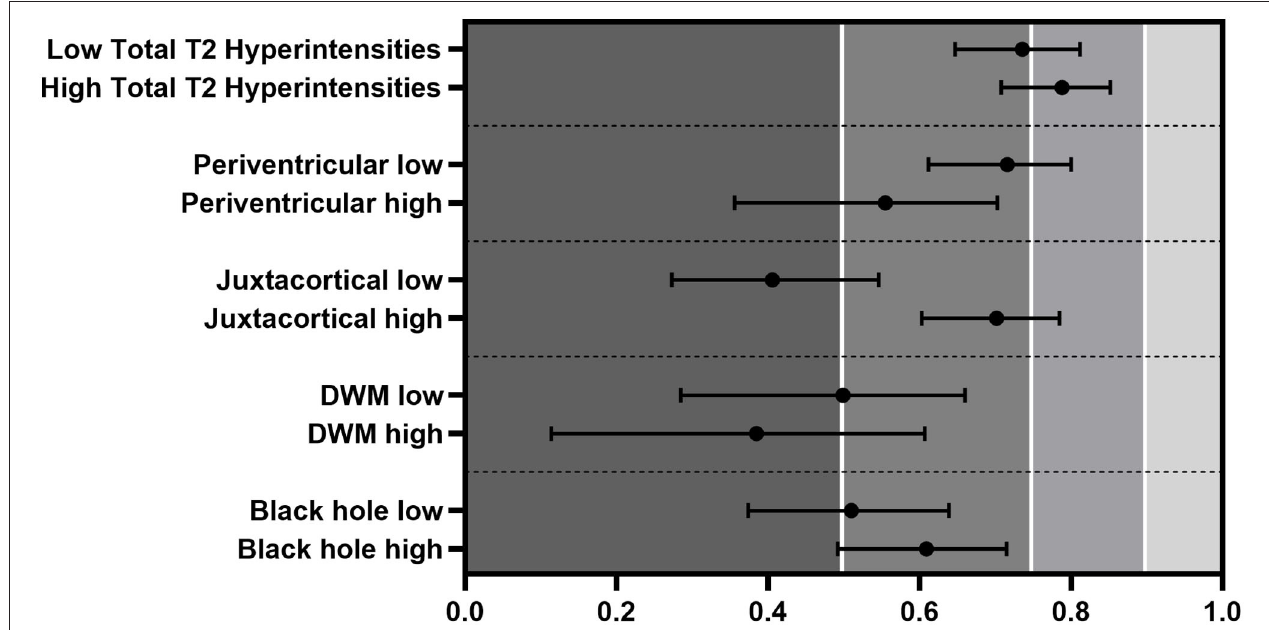
FIGURE 4 | ICC differences between low- and high-lesion counts evaluated by the four closest. The classification of juxtacortical lesions was significantly lower when the juxtacortical lesion burden was low. Error bars represent